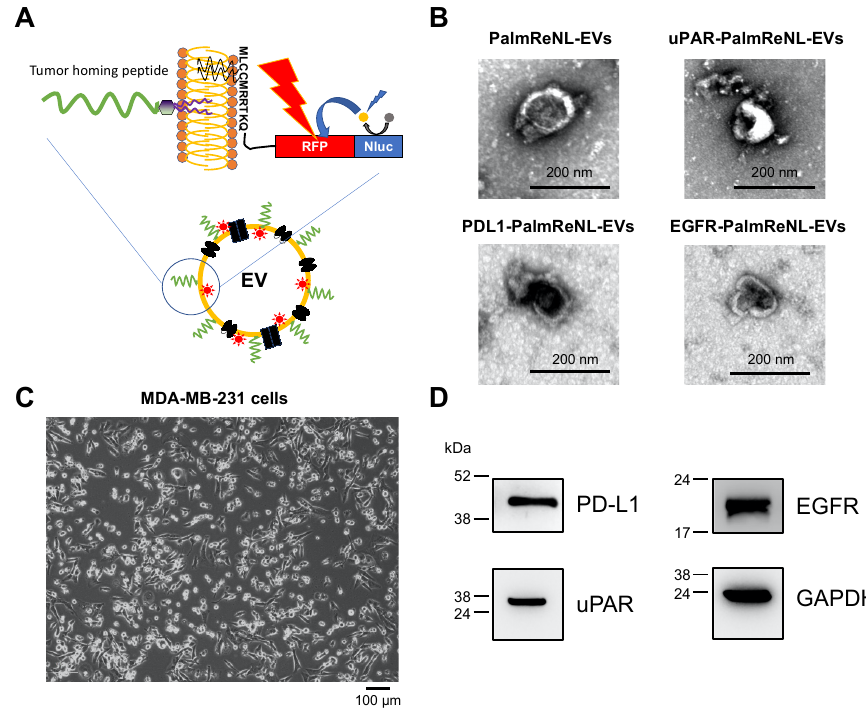
Figure 2. Engineered PalmReNL-EVs with tumor-homing peptides (THPs). ( A ) Schematic diagram of EV membrane labeling with PalmReNL BRET probes and functionalization with THP-coupled lipid nanoprobes. ( B ) Transmission electron microscopy of HEK293FT cell-derived PalmReNL-EVs with or without uPAR-, PDL1-, and EGFR-binding peptides. Scale bar, 200 nm. ( C ) A phase contrast image of MDA-MB-231 cells. Scale bar = 100 µm. ( D ) Western blot analysis of the target membrane protein expression in MDA-MB-231 cells under the non-reducing condition. GAPDH is a loading control.